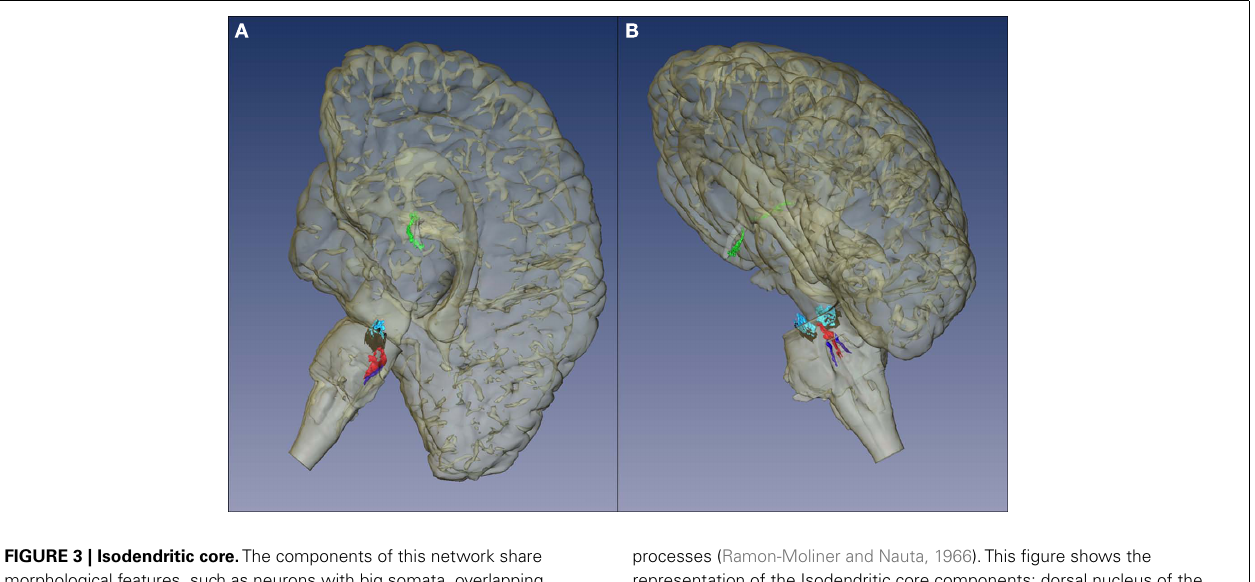
FIGURE 3 | Isodendritic core. The components of this network share morphological features, such as neurons with big somata, overlapping dendritic fields, predominantly poorly myelinated axons that extend to distant projection sites, and aminergic/cholinergic volume transmission.The isodendritic core is involved in modulation of many basic physiologic